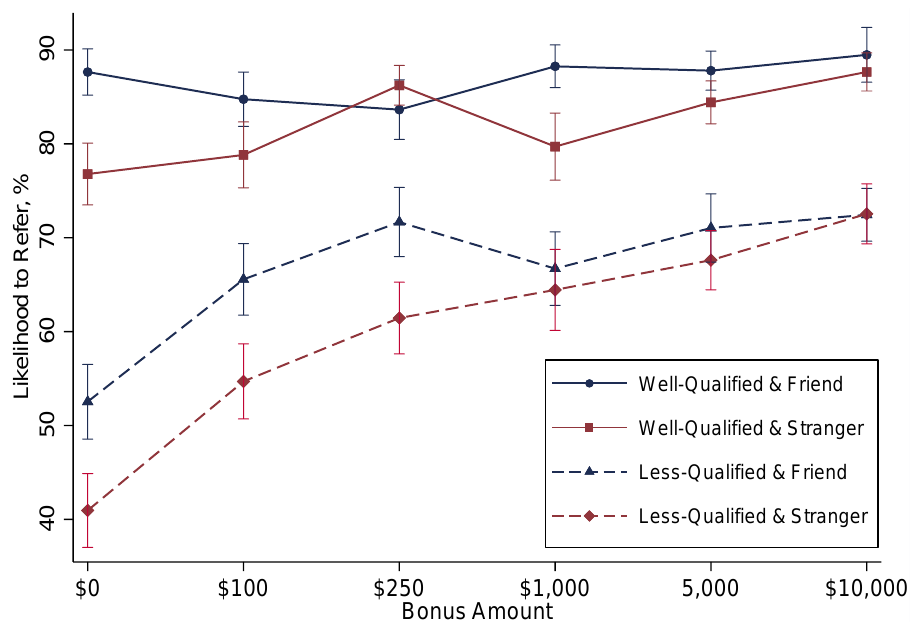
Figure 3: Candidate quality dominates strength-of-tie considerations in referral